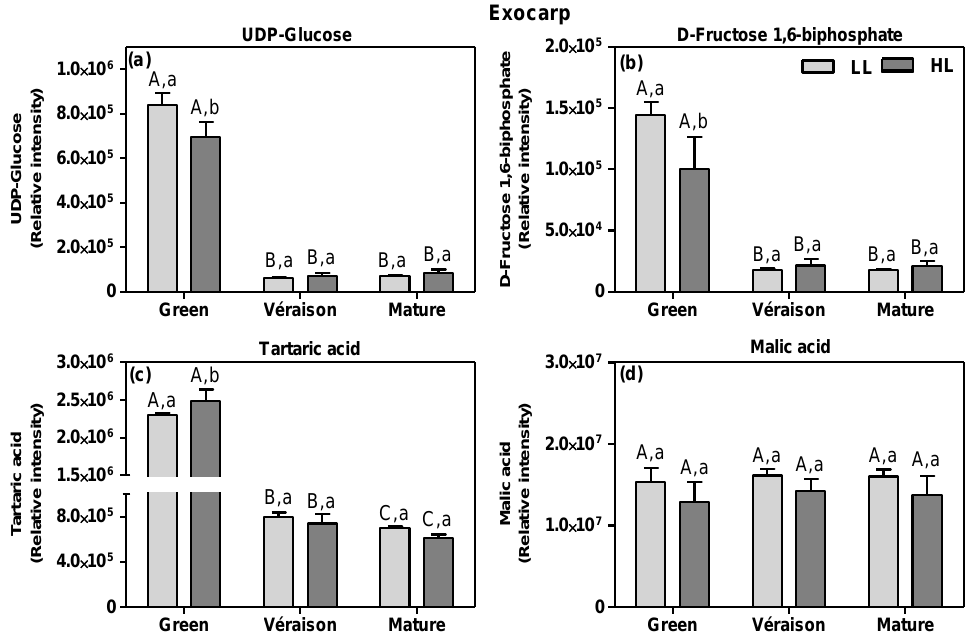
Figure 7. Relative intensity of some sugars ( a , b ) and organic acids ( c , d ) detected by LCMS (means + SD, n = 8–12) in exocarps of grapes grown in two light microclimates (LL and HL; independent of mitigation treatment) and harvested at three developmental stages (green, véraison and mature). ( a ) UDP-glucose (ID 97), ( b ) D -fructose 1,6-biphosphate (ID 79), ( c ) tartaric acid (ID 168) and ( d ) malic (ID 51) acid. See Figure 3 for statistical information.